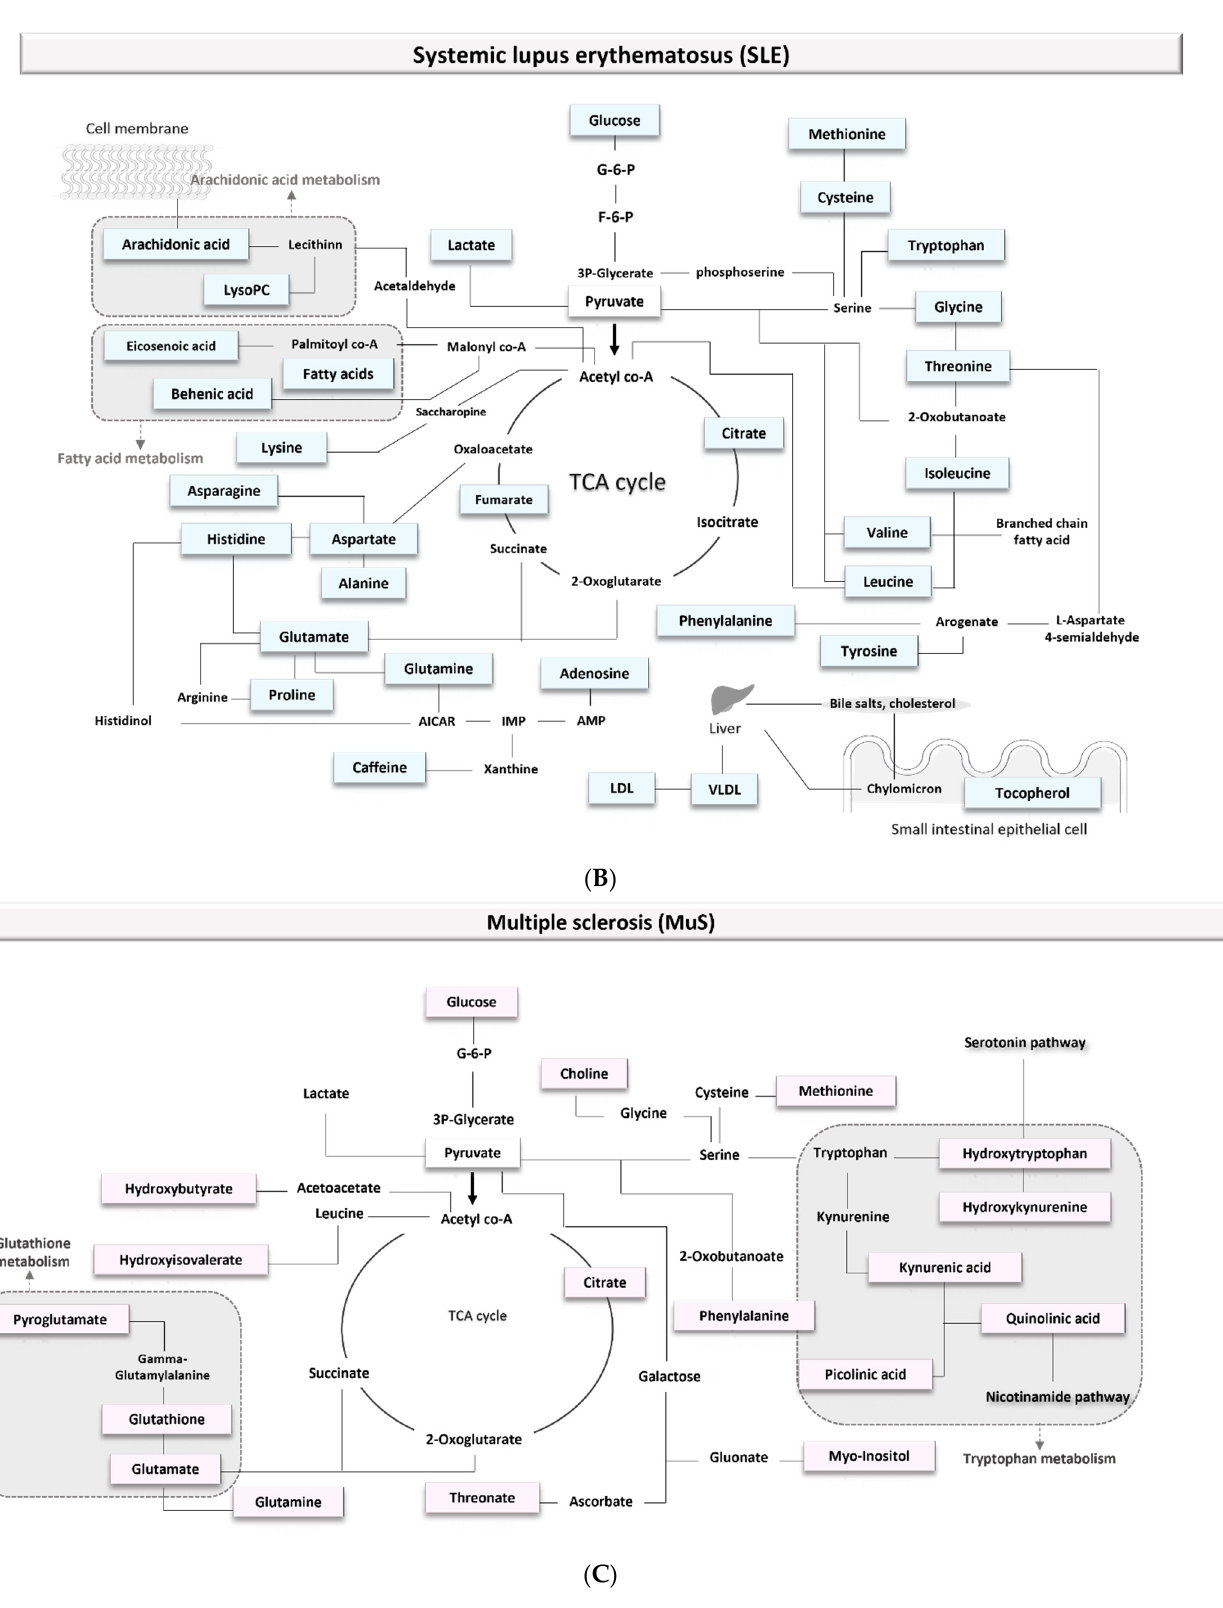
Figure 2. Overview of metabolic pathways involved in ADs. ( A ) Rheumatoid arthritis (RA); ( B ) Systemic lupus erythematosus (SLE); ( C ) Multiple sclerosis. TCA, tricarboxylic acid cycle or Krebs cycle; G-1-P, glucose 1-phosphate; G-6-P, glucose 6-phosphate; F-6-P, fructose-6-phosphate; AMP, adenosine monophosphate; IMP, inosine monophosphate; AICAR, 5-Aminoimidazole-4-carboxamide ribotide; LDL, low-density lipoprotein; VLDL, very-low-density lipoprotein.